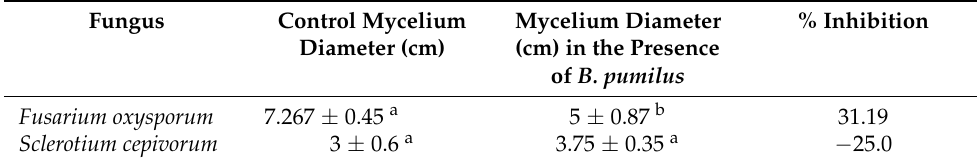
a,b Statistically significant differences between the Tukey treatments for p ≤ 0.05.